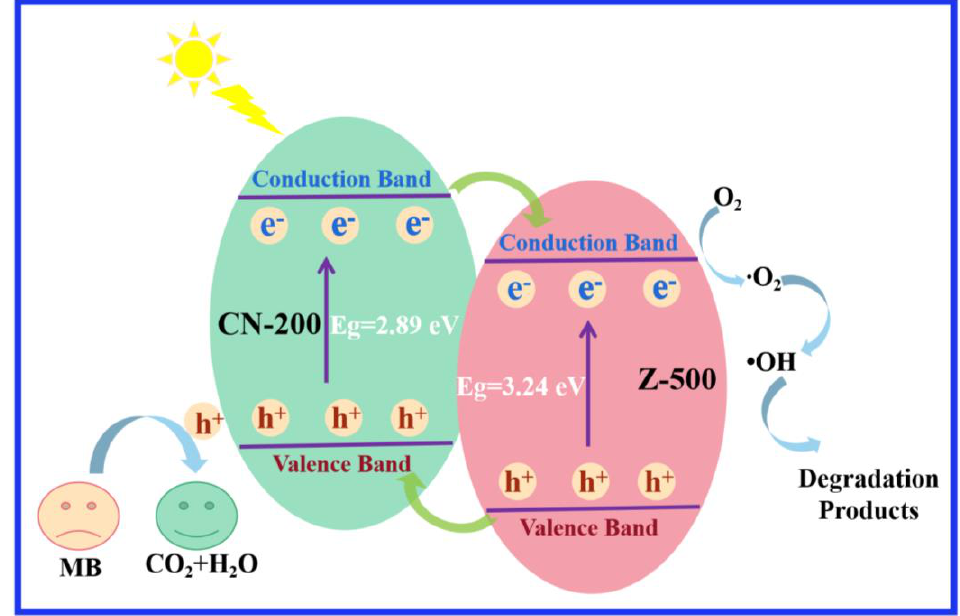
Figure 8. Schematic diagram for the proposed photocatalytic reaction mechanism of 10 wt.% CN- 200/Z-500.